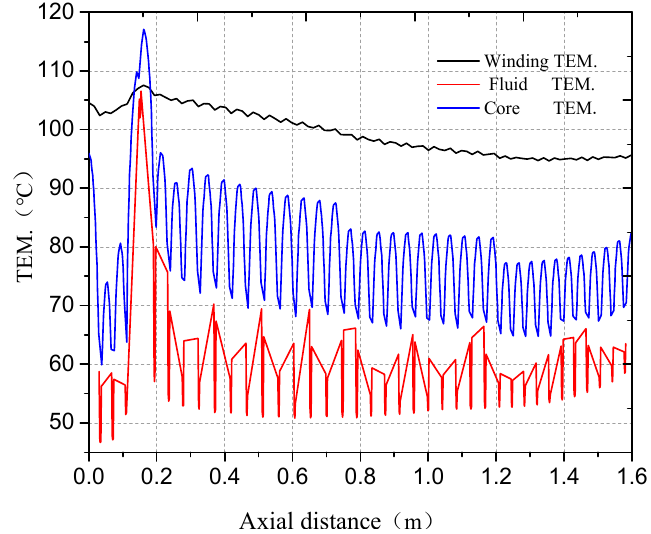
Figure 12. Winding and core temperature distribution at air gap inlet velocity 85 m/s.